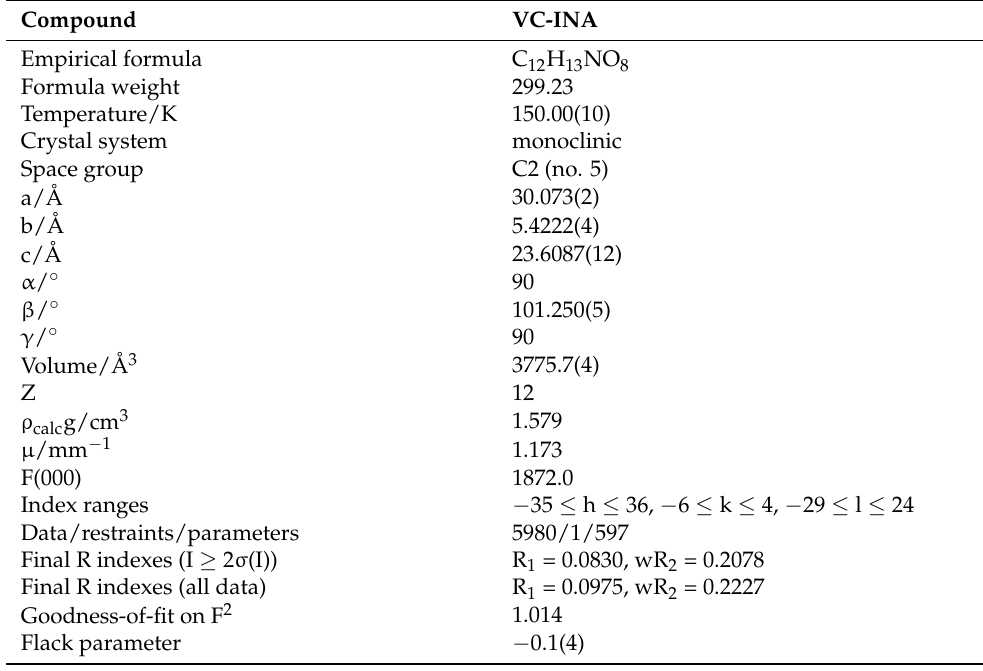
Table 1. Crystallographic data of the VC-INA